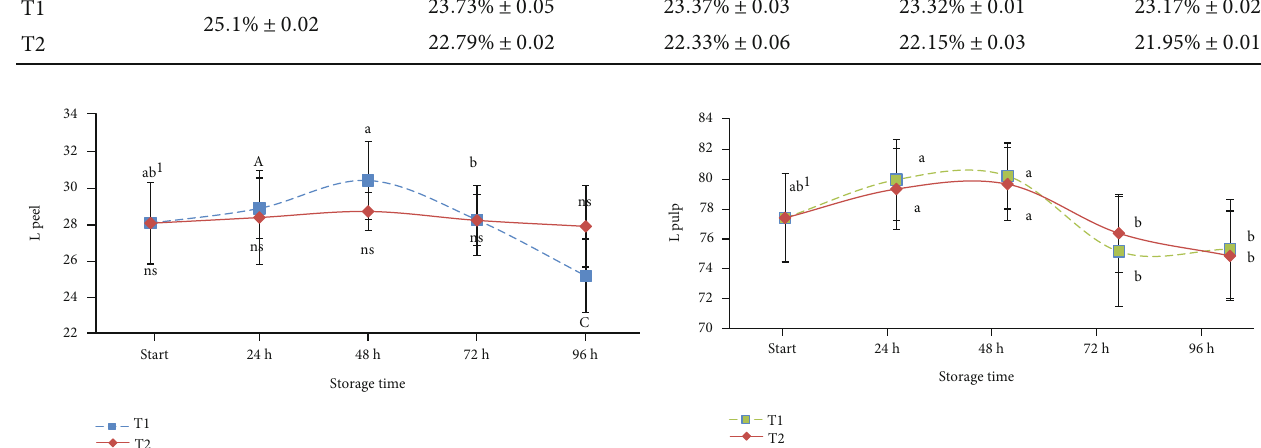
Table 2: Dry matter (DM) content (%) of avocado cv. Hass during the storage period. Samples